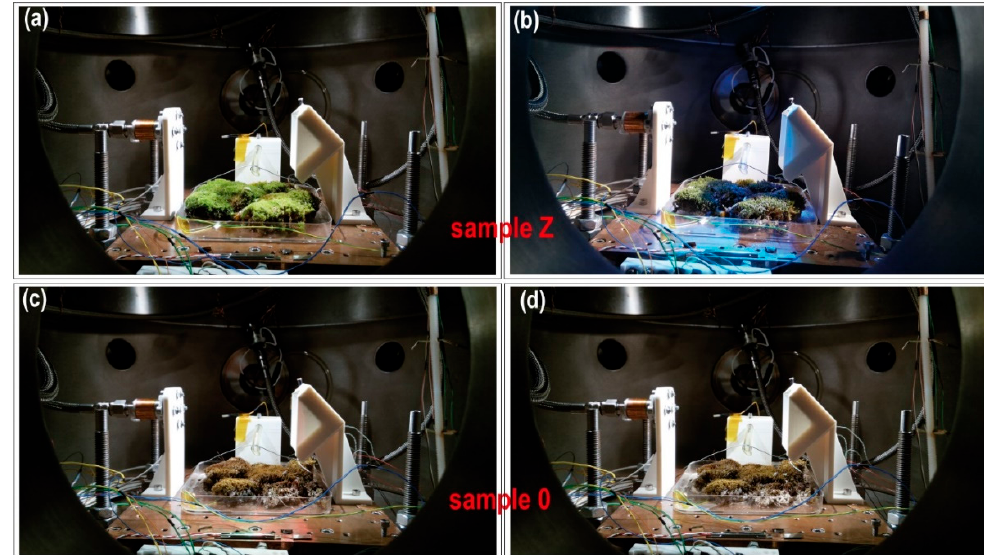
Figure 12. Photographs of the moss sample. ( a ) Photograph of sample Z before the simulation. ( b ) Photograph of sample Z after SOL 5. ( c ) Photograph of sample 0 before the simulation. ( d ) Photograph of sample 0 after SOL 5.